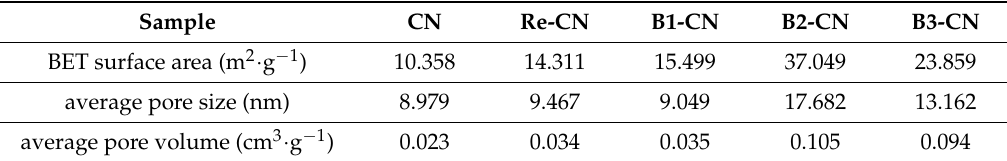
Figure 4. Nitrogen adsorption/desorption isotherm profiles for ( a ) CN (black); ( b ) Re-CN (blue); ( c ) B1-CN (red); ( d ) B2-CN (yellow); and ( e ) B3-CN (purple). Table 1. BET surface area, average pore size, and pore volume of CN, Re-C 3 N 4 , and CN/B 2 O 3 series composite materials.